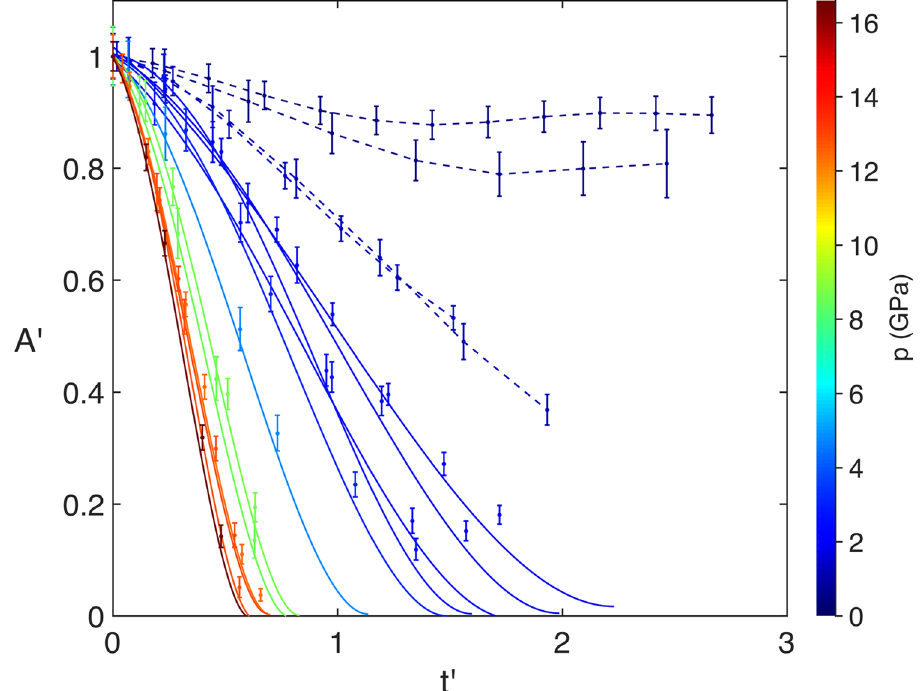
Figure 6. Plots of A ′ vs. t ′ . The colour bar shows the shock pressure p . In the low-pressure region the dashed lines show the trajectory of the projected area, with a piecewise linear interpolation between each point. In the higher-pressure region the solid lines show the fitting of each curve with Eq. 4.